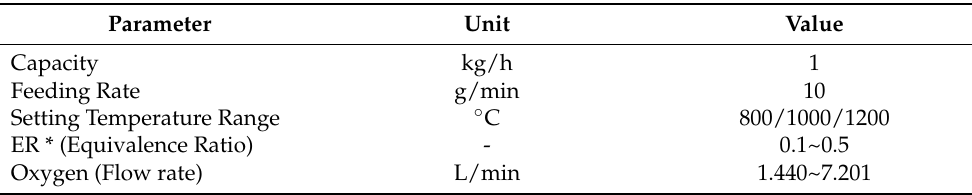
Figure 1. Process Diagram of Fixed-bed Gasification System. 1. Oxygen supply; 2. Oxygen controller; 3. Mass flow controller; 4. Feeder; 5. Feeding pipe; 6. Reactor with heater; 7. Cyclone; 8. Residue collector; 9. Scrubber‘ 10. Fabric filter; 11. Water pump; 12. Filtering system; 13. Silica gel; 14. Gas vacuum pump; 15. Syngas controller; and 16. Micro-GC, TC Thermocouples. Table 3. Experimental Conditions of Gasification at a Fixed-bed